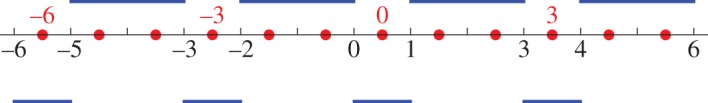
The periodic drift μ with α=13 and L=3 is plotted on the interval [−6,6]. Each interval [j,j+1) (in black) is replaced by its midpoint j+12, which we relabel as j (in red) to discretize space. To discretize time as well, we replace the Brownian motion by a simple symmetric random walk on Z, and we replace the Brownian ratchet by an asymmetric random walk on Z whose periodic state-dependent transition probabilities are determined by a discretized version of μ.